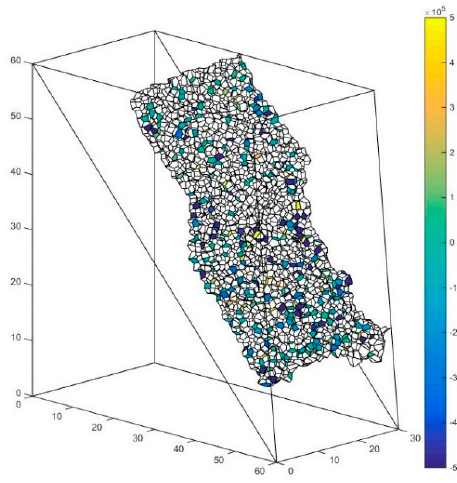
Figure 19. The contact force of the particle contact along the x-direction.